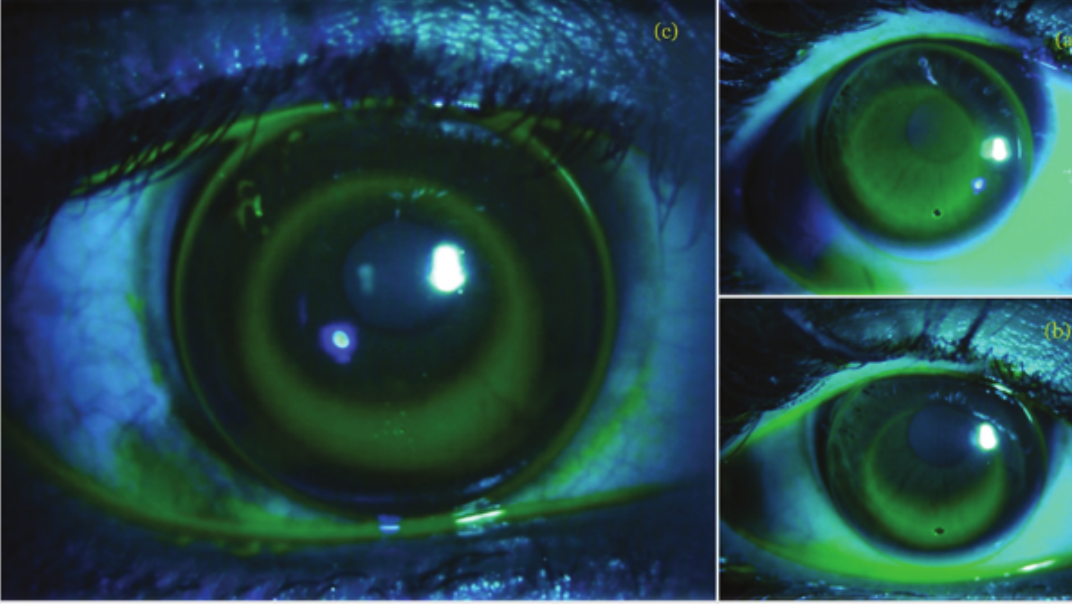
Figure 1. Sequential fitting from steep fit to ideal fit during trial fitting of an orthokeratology patient.